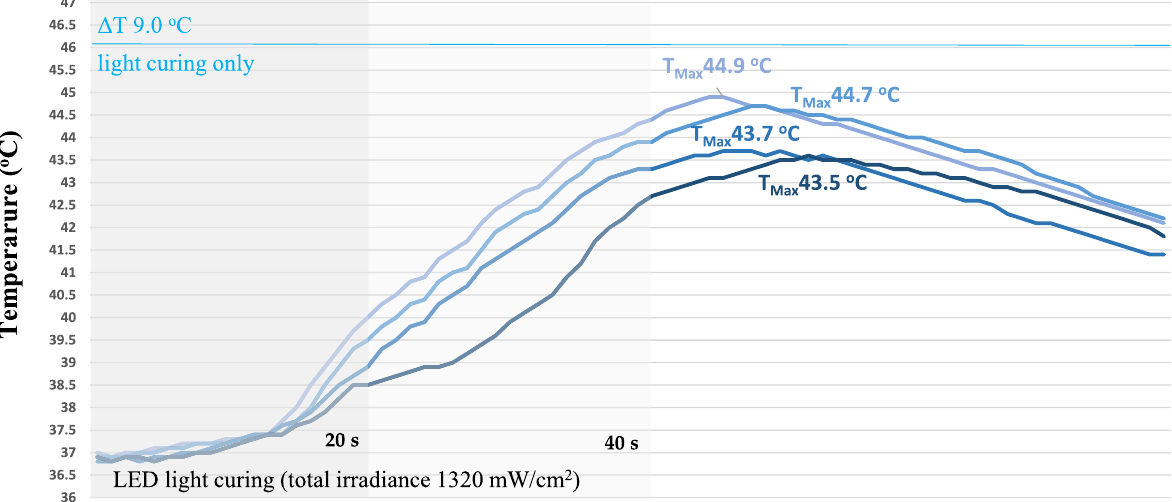
Figure 2. Representative registration curves of pulpal temperatures measured during irradiation through different thicknesses of ceramic veneers without resin luting